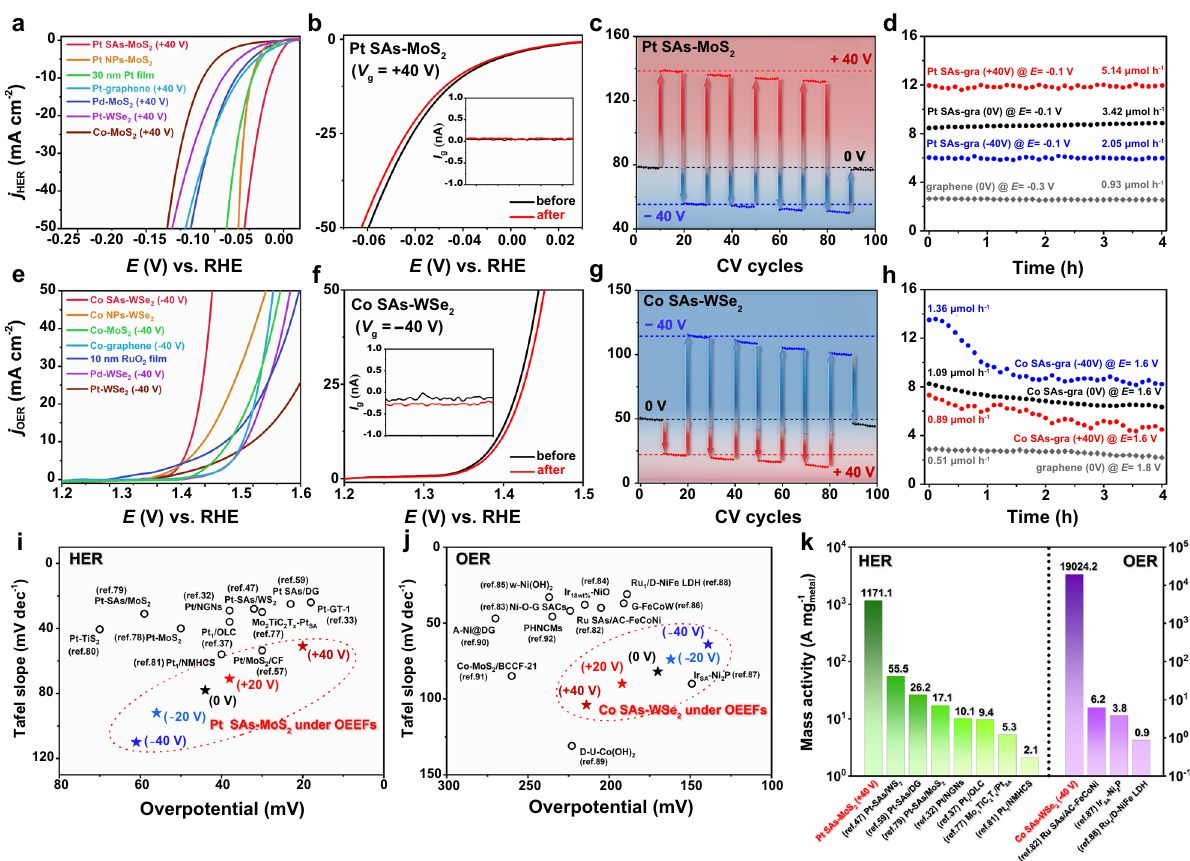
Fig. 5 Electrocatalytic performance and stability of model SACs through “ onsite electrostatic polarization ” modulation. a HER polarization curves of 2D SACs (at optimal OEEFs) and the control catalysts. b HER polarization curves of Pt SAs-MoS 2 ( V g = + 40 V) before (black) and after (red) 100 CV cycles, in the potential range of − 0.1 V to 0.1 V (vs. RHE). Inset (with identical abscissa) depicts the recorded leakage current. c Electrochemical current density ( j HER ) of Pt SAs-MoS 2 at E = − 0.1 V (vs. RHE) recorded in a 100-cycle HER test, with V g switching between − 40 V and + 40 V every ten cycles. d Chronoamperometric curves in a 4-h potentiostatic HER test of pristine graphene and Pt SAs-graphene under OEEF regulation. The formation rates of H 2 are added alone each curve. Note that the ordinates in a – d all correspond to HER current density ( j HER ). e OER polarization curves of 2D SACs (at optimal OEEFs) and the control catalysts. f OER polarization curves of Co SAs-WSe 2 ( V g = − 40 V) before (black) and after (red) 100 CV cycles, in the potential range of 1.1 V to 1.5 V (vs. RHE). Inset (with identical abscissa) depicts the recorded leakage current. g Electrochemical current density ( j OER ) of Co SAs- WSe 2 at E = 1.45 V (vs. RHE) recorded in a 100-cycle OER test, with V g switching between − 40 V and + 40 V every ten cycles. h Chronoamperometric curves in a 4-h potentiostatic OER test of pristine graphene and Co SAs-graphene under OEEF regulation. The formation rates of O 2 are added alone each curve. Note that the ordinates in e-h all correspond to OER current density ( j OER ). i Summarized HER performance of Pt SAs-MoS 2 (with varying V g ) and previously reported electrocatalysts. j Summarized OER performance of Co SAs-WSe 2 (with varying V g ) and previously reported electrocatalysts. k Mass activity of 2D SACs (at optimal OEEFs) in this work and several representative up-to-date catalysts. The green bars for HER at η HER = − 0.05 V and the purple bars for OER at η OER = 0.2